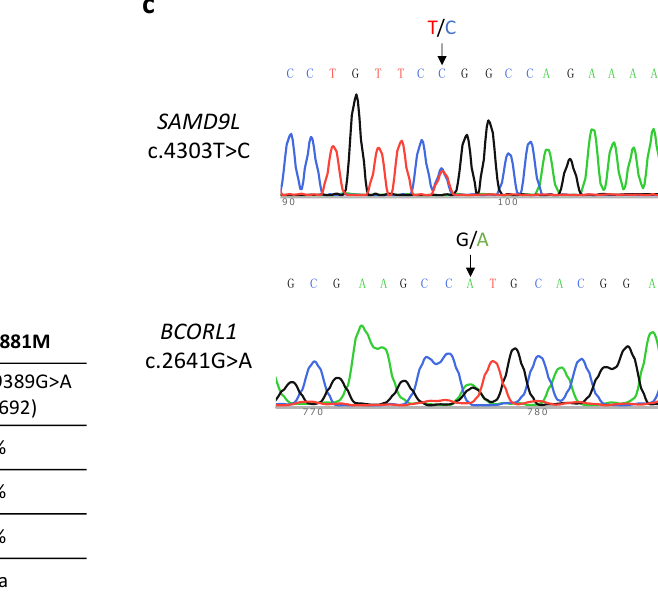
parainfluenza B infection at 10.5 years of age, leading to a diagnosis of relapsed AA (Figure 1). Case 3, though having responded to a rabbit ATG/cyclosporine regimen and being subjected to a tapering-down CSA dosage, developed alopecia areata at transfer. years after successfully undergoing PBSCT from her HLA-matched